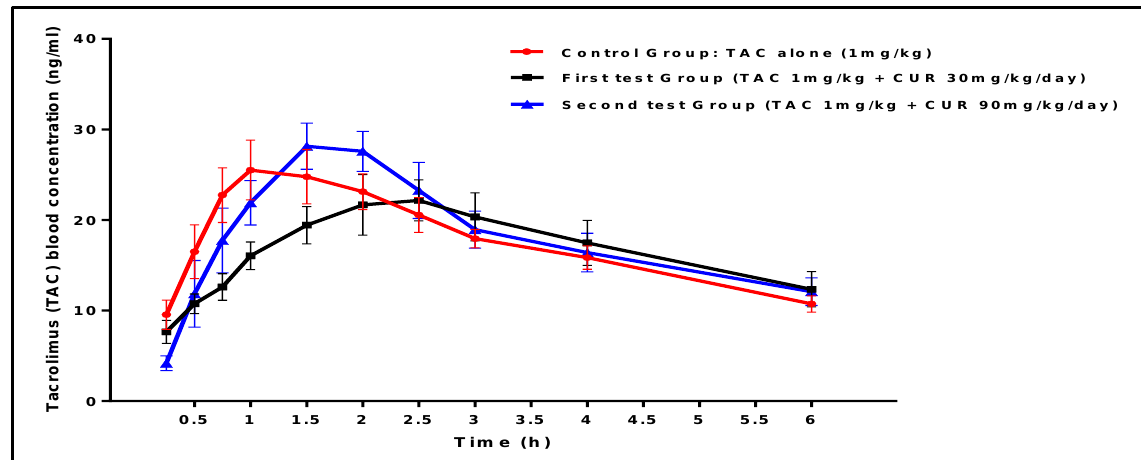
Figure 1. Plot of TAC concentration-time profile with and without CUR for the control, first and second test groups. Table 1. Calculated PK parameters of the control, the first and second test groups (6 for each). PK